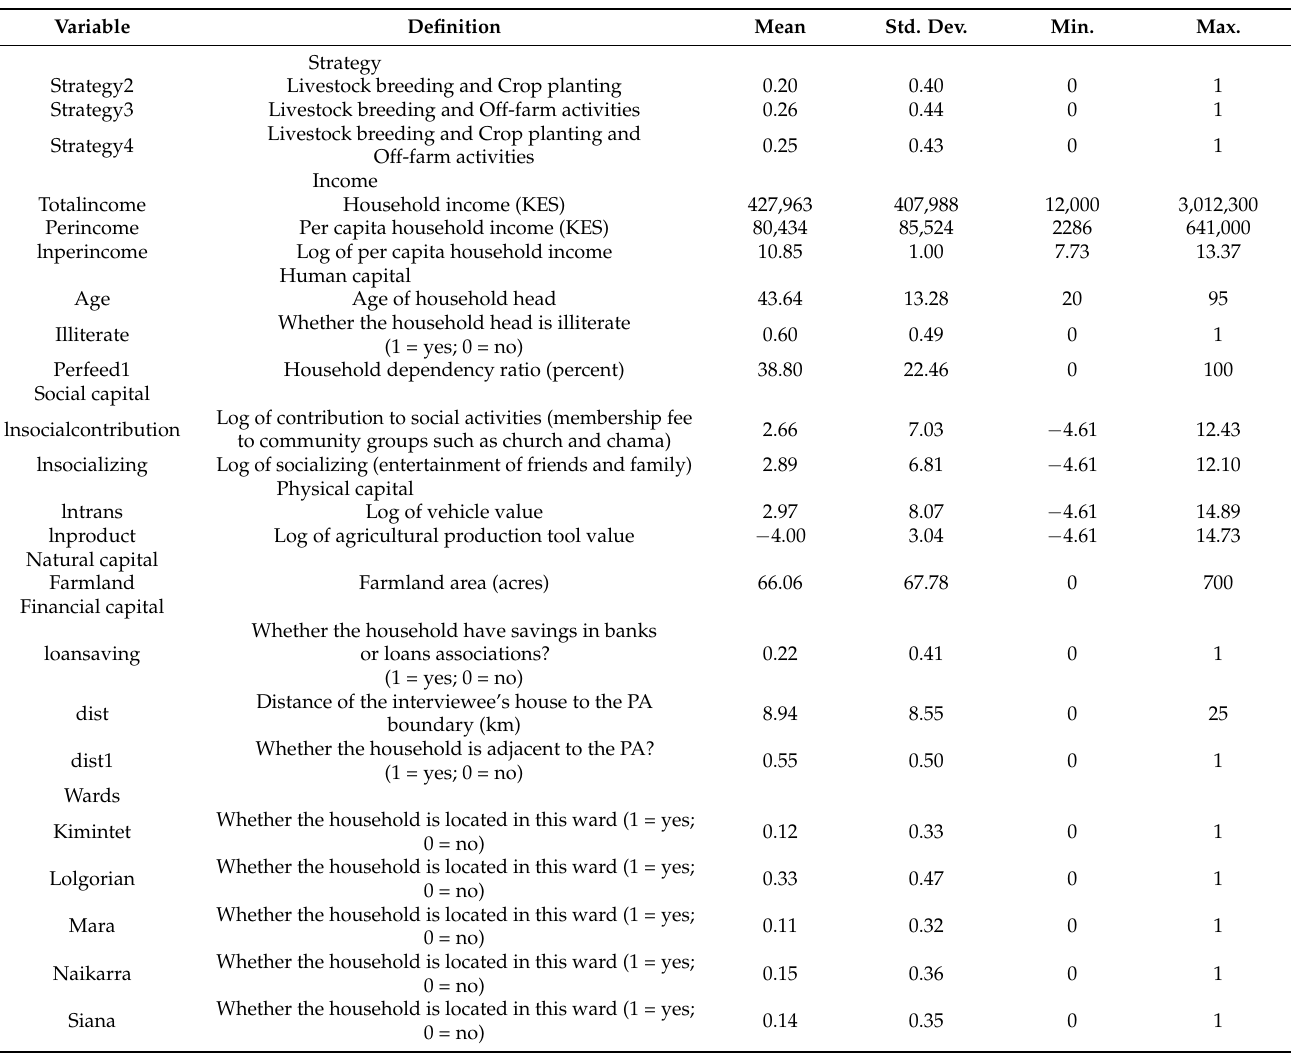
Table 1. Descriptive